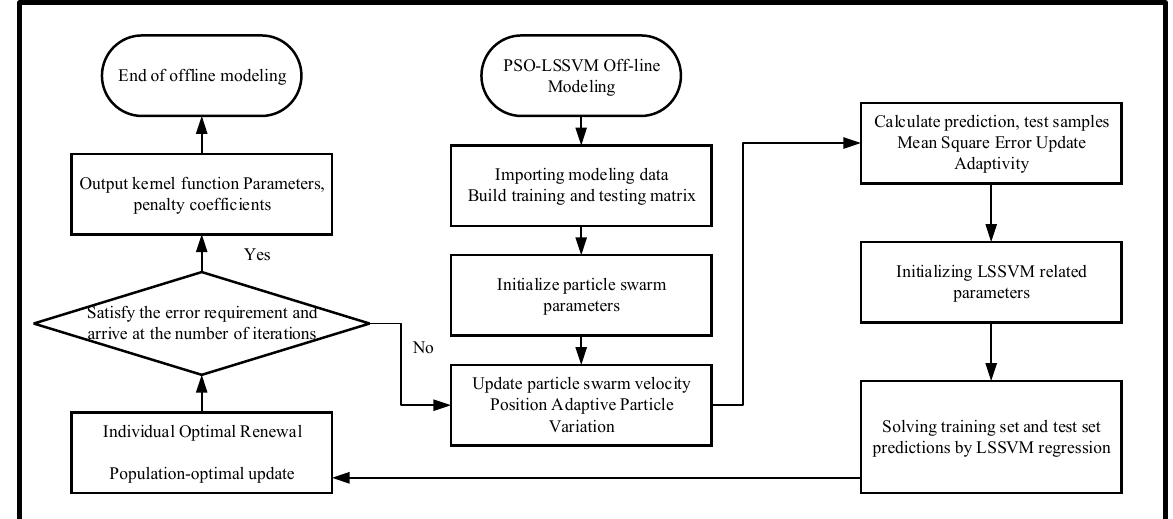
error caused by the temperature rise using a single thermal error model.